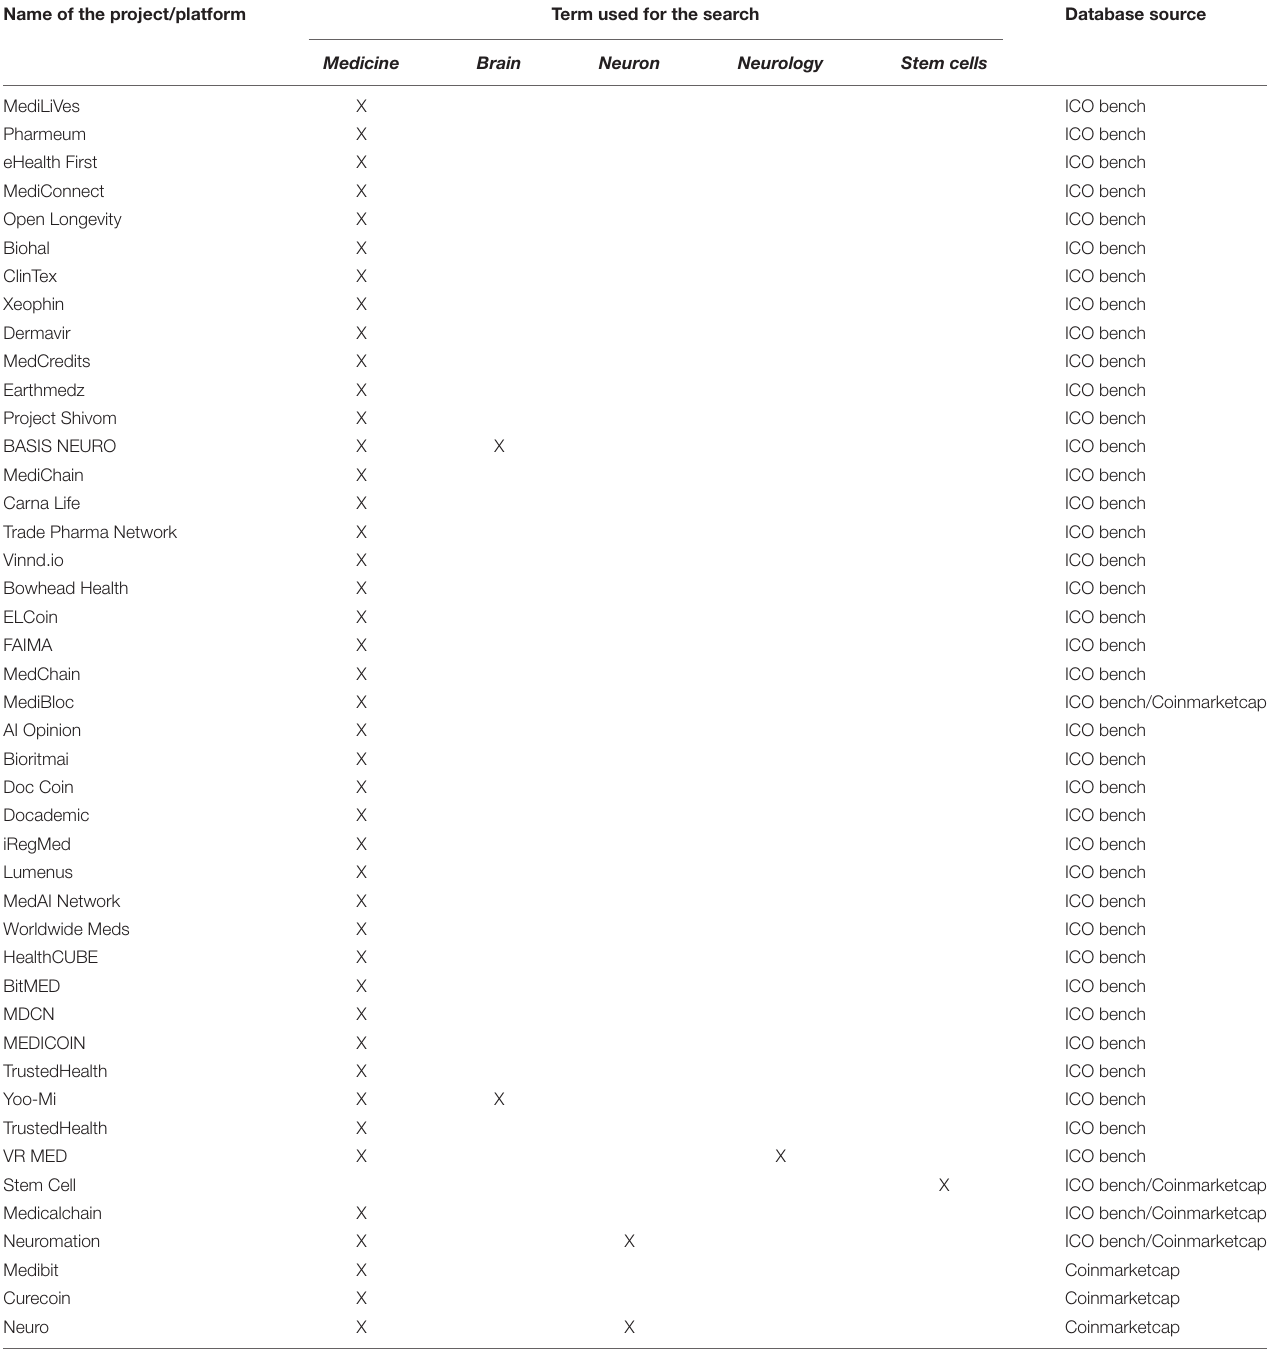
TABLE 1 | List of the projects in ICO bench and Coinmarketcap databases containing the terms “Medicine” or “Brain” or “Neuron” or “Neurology” or “Stem cells.” Name of the